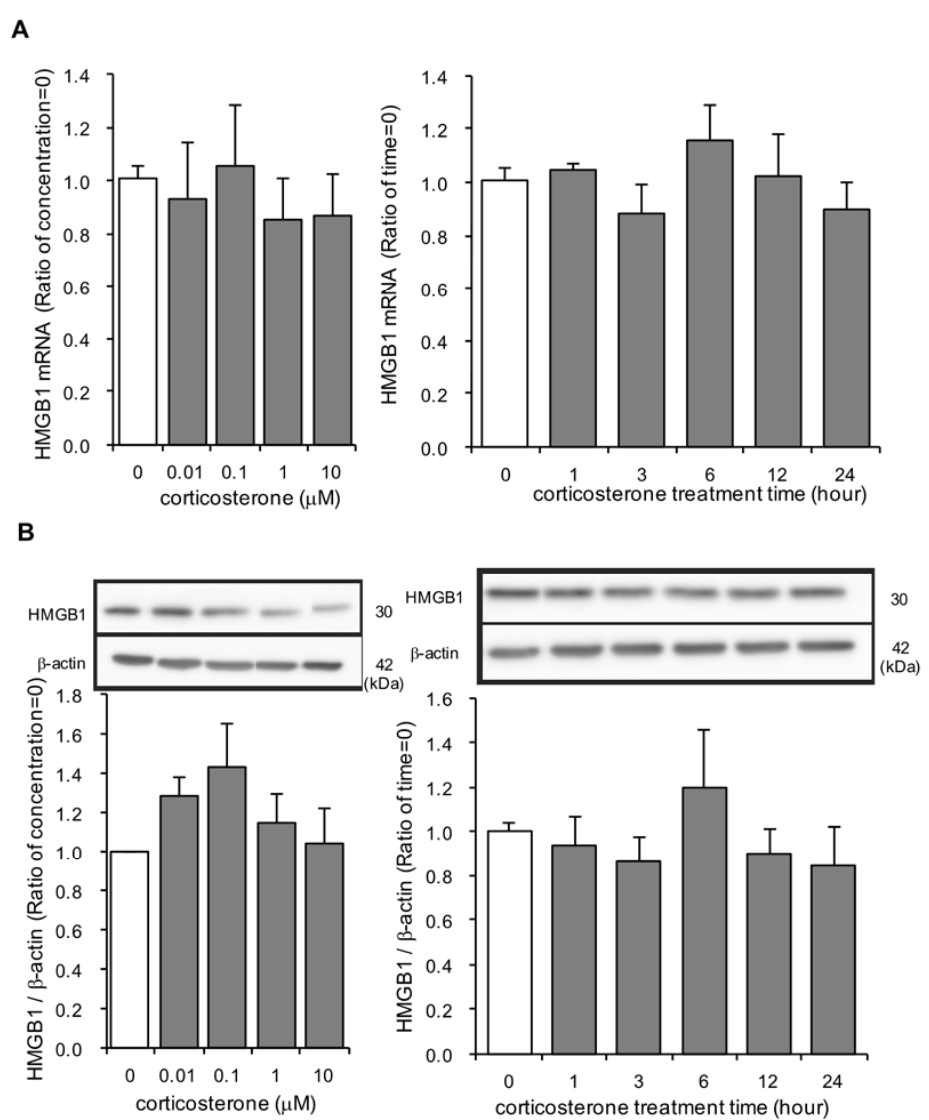
Figure 4. The effect of corticosterone on HMGB1 mRNA and intracellular HMGB1 protein expression in primary cultured cortical astrocytes. ( A ) Astrocytes were treated with 1 µ M corticosterone for the indicated periods of time or the indicated concentrations of corticosterone for 24 h. HMGB1 mRNA expression (ratio of HMGB1 mRNA: GAPDH mRNA) was quantified by real time PCR. The data are expressed as the mean ± SEM. ( n = 3–5). ( B ) Astrocytes were treated with 1 µ M corticosterone for the indicated periods of time or the indicated concentrations of corticosterone for 24 h. HMGB1 protein was quantified by Western blotting, and representative blots are shown (HMGB1: 30 kDa, β -actin: 42 kDa). The data are expressed as the mean ± SEM. ( n = 3–5).